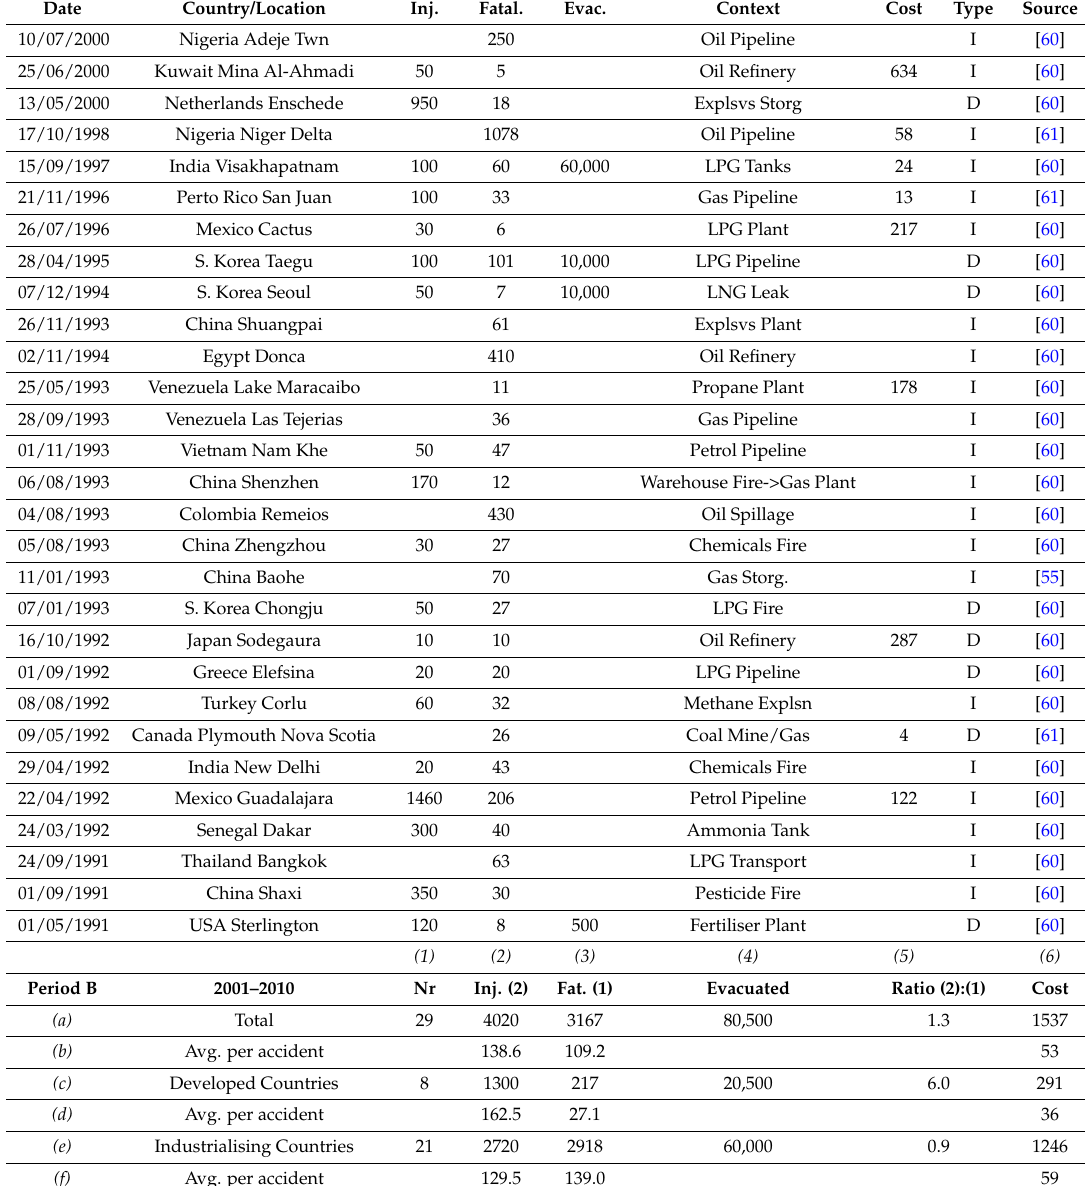
Table 2. Period B,